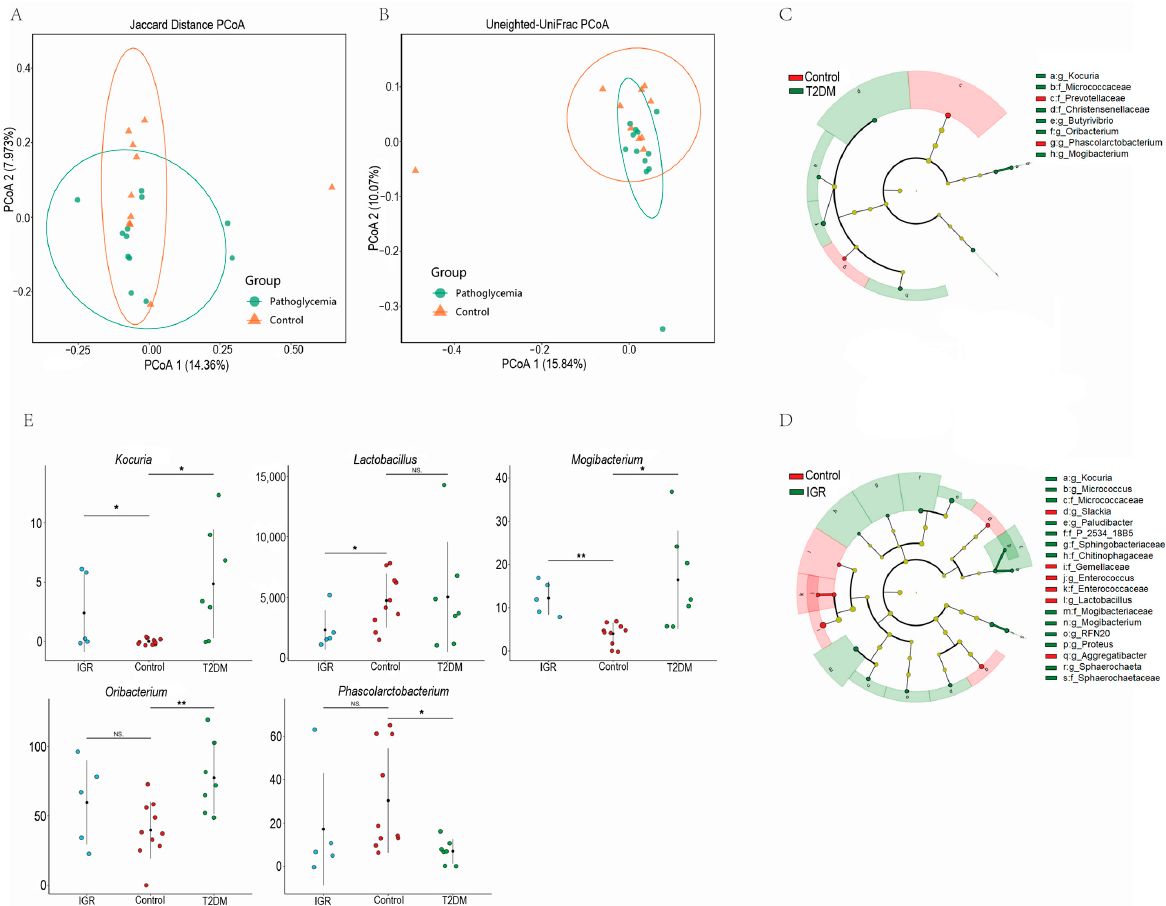
Figure 1. 16S rRNA gene amplicons analysis. Principal Co-ordinates Analysisanalysis (PCoA) of β diversity was based on the Jaccard ( A ) ( p = 0.006) and unweighted-UniFrac ( B ) ( p = 0.013) between the Pathoglycemia and Control groups. Scores plot of PCoA explain 17.3% and 25.91% of the variance, respectively. Histogram of LDA scores to identify differentially abundant bacterial genera between T2DM and Control groups ( C ), IGR and Control groups ( D ) (LDA score > 2, p < 0.05). Red indicates increased abundance in controls; Green indicates increased abundance in T2DM or IGR samples. Relative abundance across different genera between T2DM and Control groups, IGR and Control groups ( E ). Horizontal points represent the mean. Error lines plotted denote SD. * p < 0.05 and ** p <